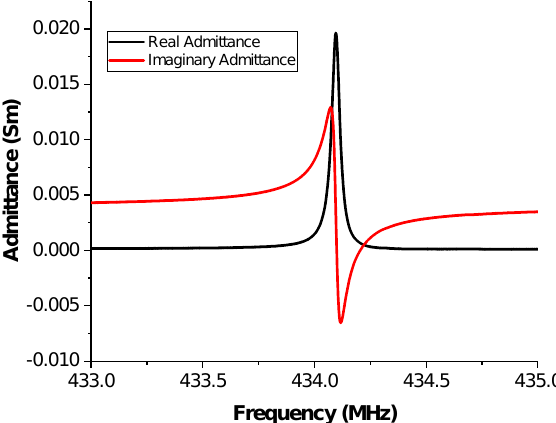
Figure 5. Resonator performance. Admittance measurements for single resonator using a vector network